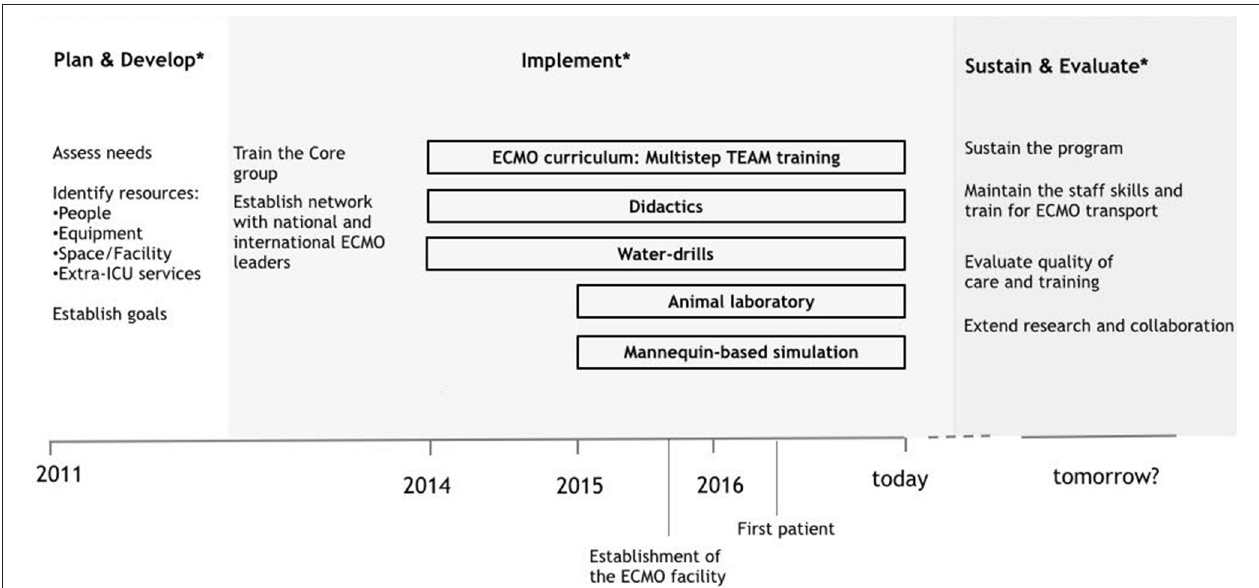
FIGURE 1 | Development of a neonatal respiratory ECMO program: timeline of key steps. *The developmental process is based on ELSO guidelines (8, 16).